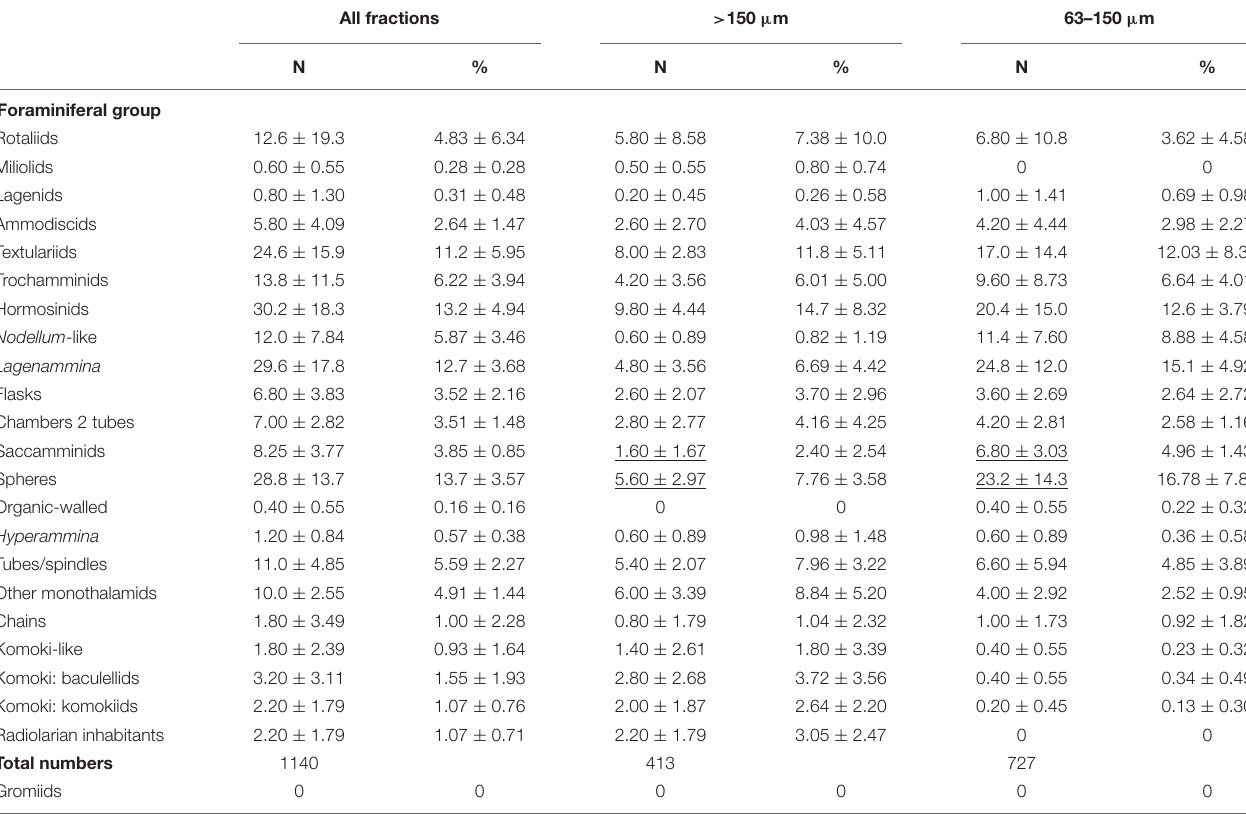
TABLE 4 | Mean and percentage abundances ( ± standard deviations) of major groups based on complete dead specimens in the two size fractions and both fractions combined of 5 samples. All